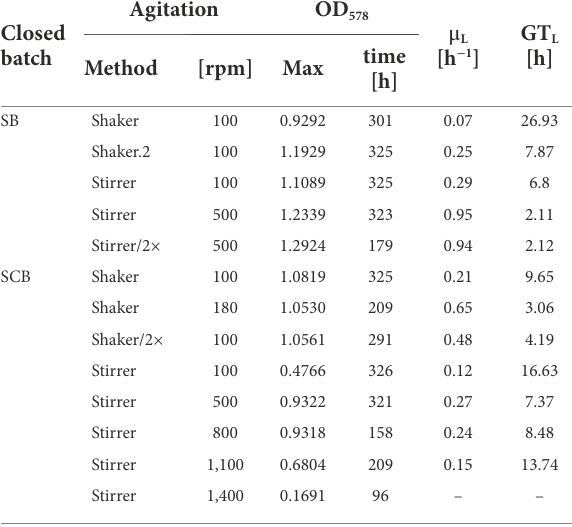
TABLE 1 Comparison of culture growth parameters from closed batch experiments.*